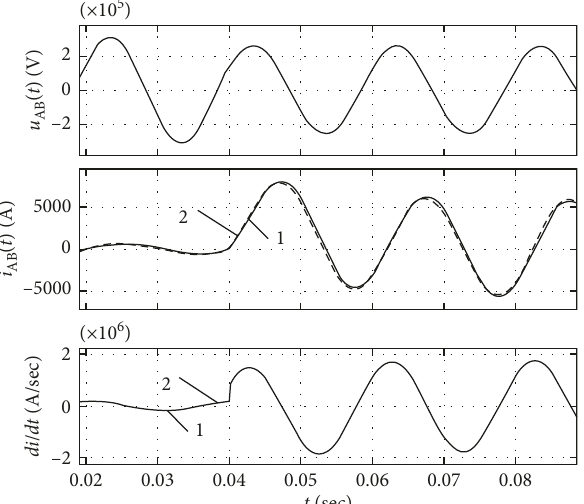
Table 4: Influence of the different electrical load values and dif- ferent distances to the fault on the first-moment fault location error.